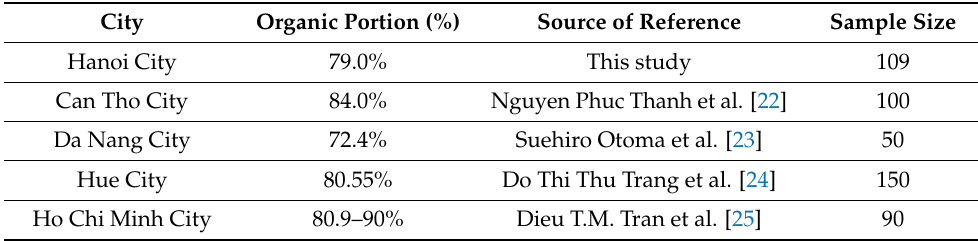
Table 5. Comparison of organic portion in other